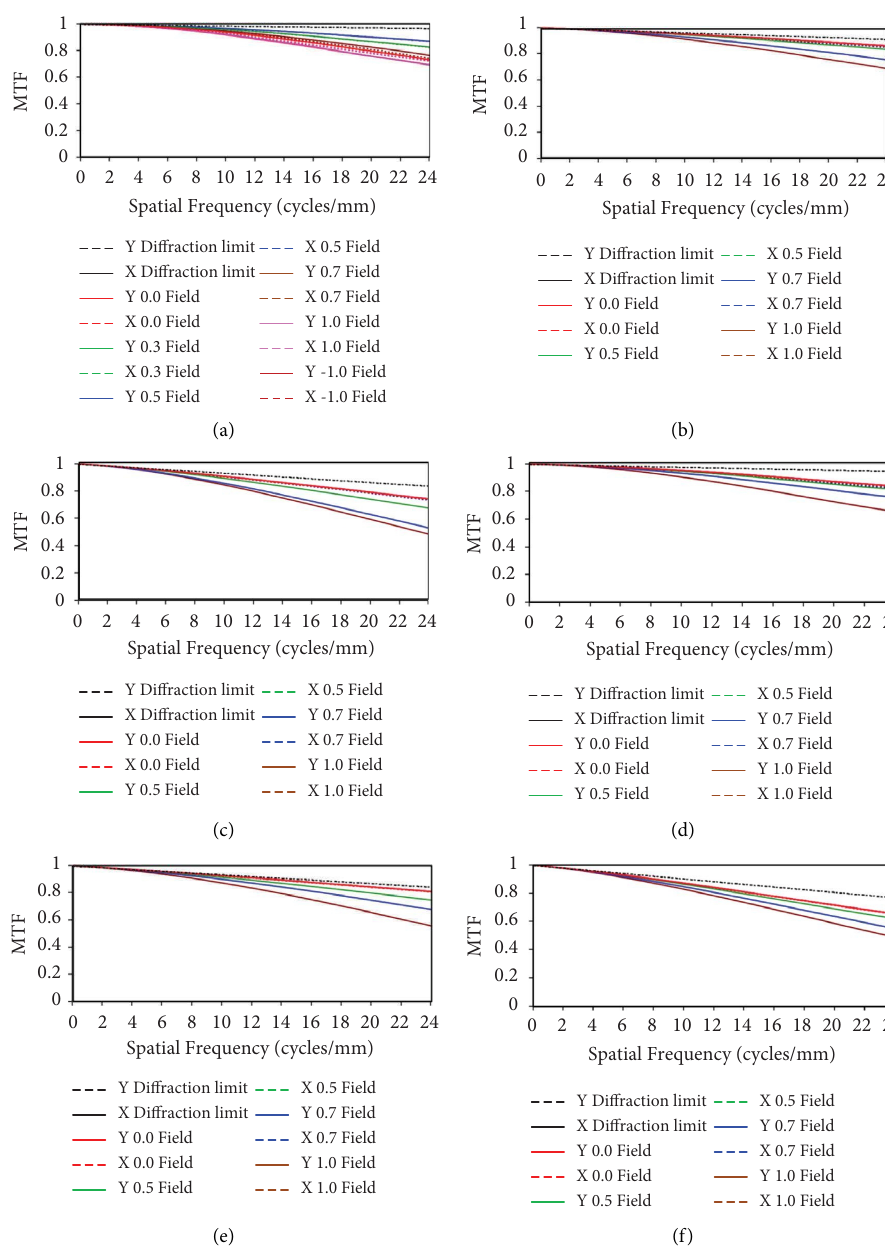
Figure 5: MTF of the periphery and foveated channels at diferent magnifcations. (a) MTF of the peripheric channel in full feld. (b)–(f) MTF of foveated channels in the foveated feld at 2 × , 3 × , 5 × , 7 × , and 9 × magnifcations,